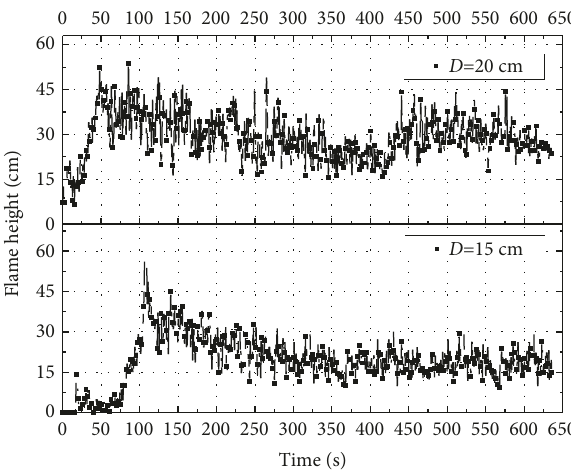
Figure 10: Flame height in the chamber varies with time.